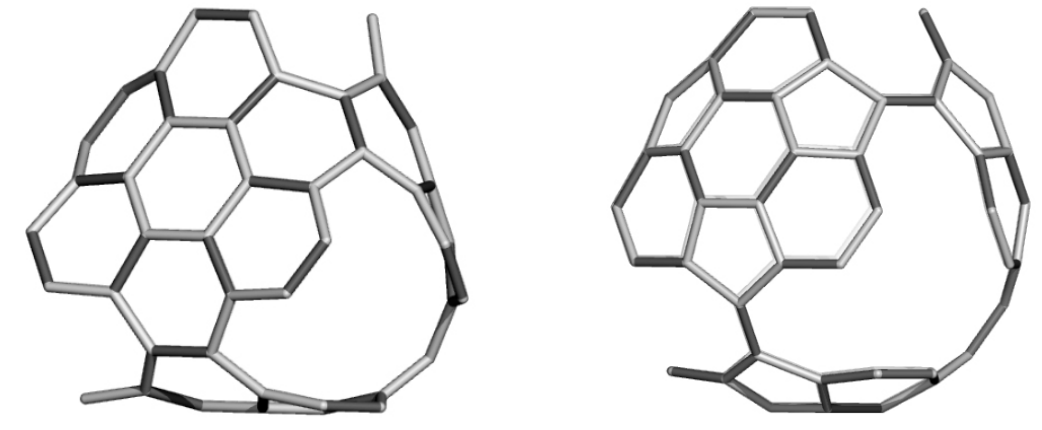
Figure 4. The tetrahedrally spanned fullerenes patched by coronene (Cor_T_84, left) and sumanene (Sum_T_84, right). Table 7. The total energies E , total energy per number of C atoms E tot based on coronene and sumanene, respectively and the reference C